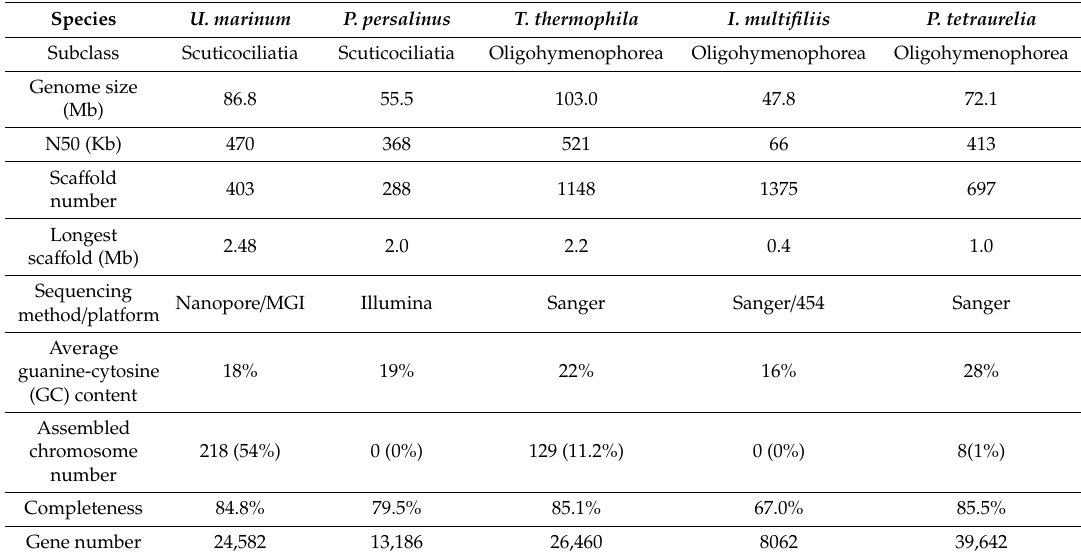
Table 1. Statistics of the assembled macronuclear (MAC) genomes for five ciliates.